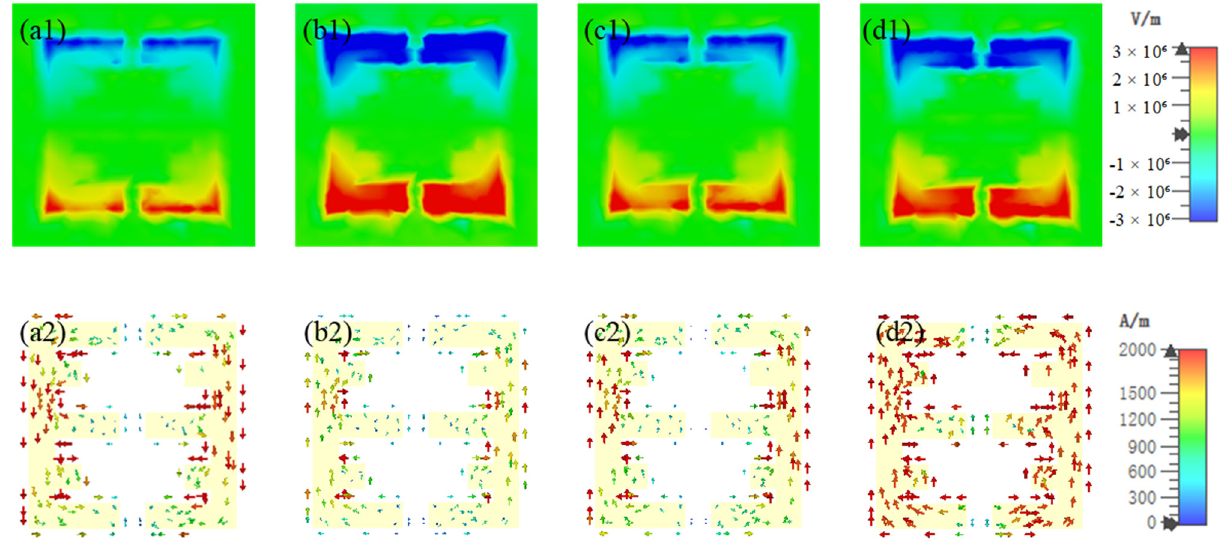
Figure 3. ( a1 – d1 ) Electric field distributions of the four-band sensor in the ƒ 1 , ƒ 2 , ƒ 3 , and ƒ 4 modes (Re.Ez, z = 0 plane). ( a2 – d2 ) Surface current distributions of the four-band sensor in the ƒ 1 , ƒ 2 , ƒ 3 , and ƒ 4 modes (z = 0 plane).